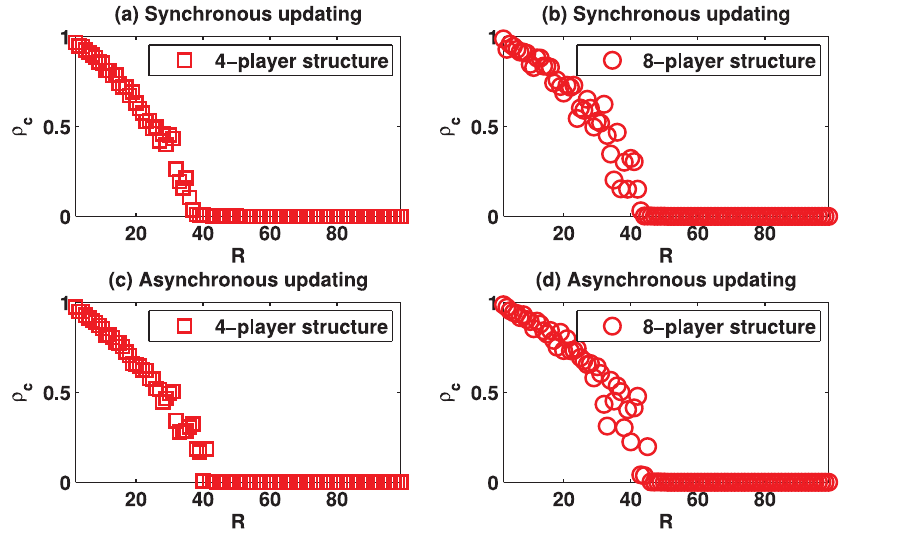
Figure 4. (Color online) Cooperation level r c as a function of the parameter R on different square lattices under the best-take-over rule with power-law initial strategy distribution. (a) Results on the square lattice with 4-player neighborhood and synchronous updating; (b) Results on the square lattice with 8-player neighborhood and synchronous updating; (c) Results on the square lattice with 4-player neighborhood and asynchronous updating; (d) Results on the square lattice with 8-player neighborhood and asynchronous updating.